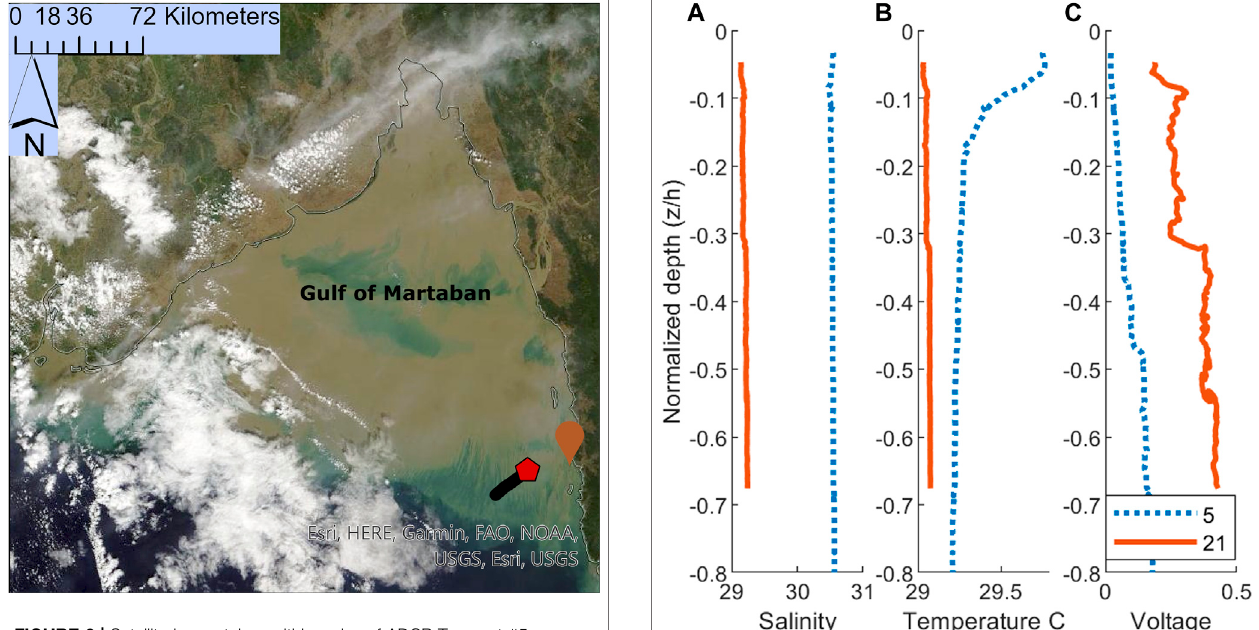
FIGURE 3 | Satellite image taken within a day of ADCP Transect #5. Location of transect (black line) and CTD-Tu (red circle) shown. Duya, Myanmar shown as orange marker. Image from NASA Worldview. FIGURE 4 | Vertical pro fi les of (A) Salinity, (B) Temperature, and (C)